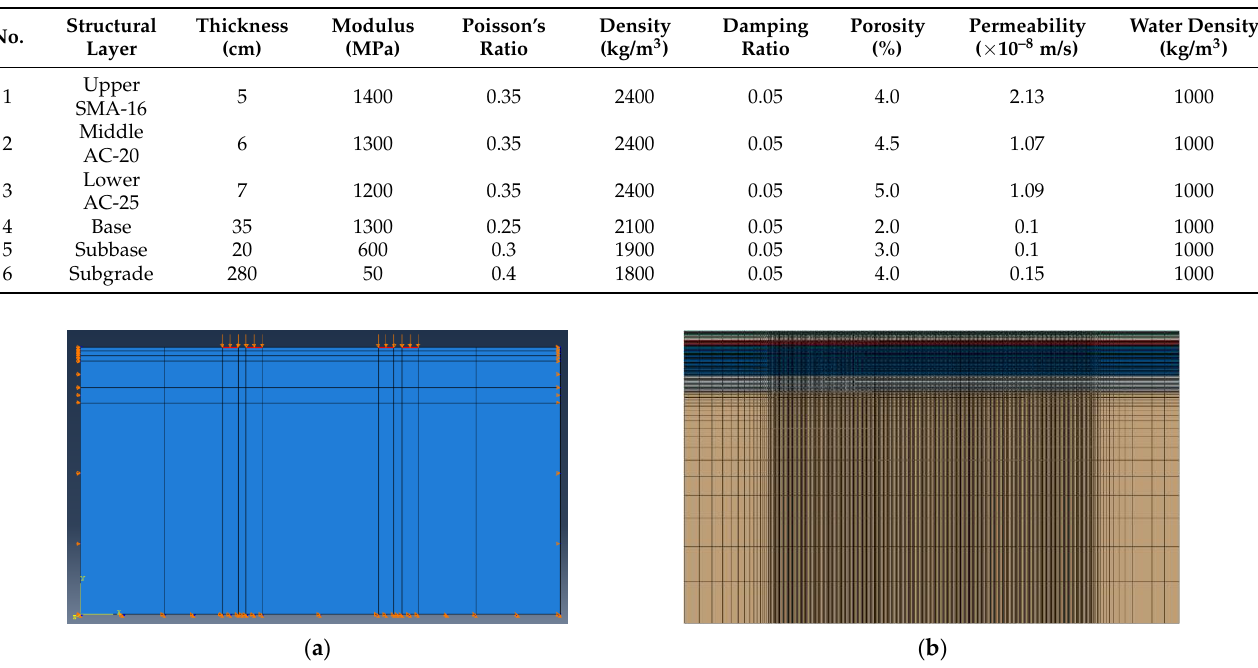
Table 1. Structure and material parameters of FEM model for asphalt pavement.